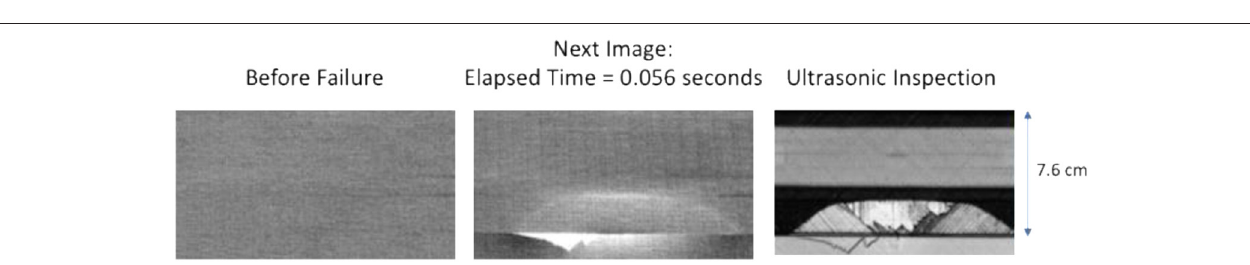
FIGURE 4 | Single pixel plot of surface heating showing instantaneous heating response for small delamination.